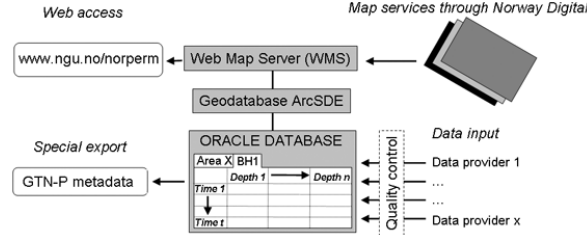
Figure 5. NORPERM data management structure. Data is